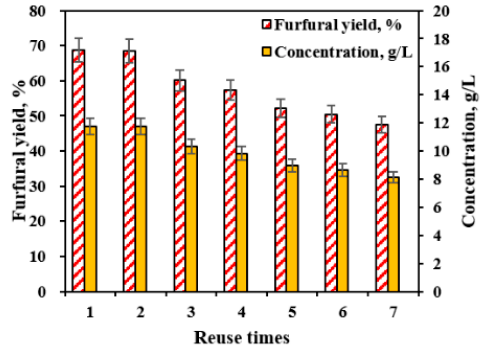
Figure 4. Reuse of CSUTS-CSW in toluene–water (2:1, v : v ) (75 g/L CC, 3.6 wt% CSUTS-CSW, NaCl (200 mM), 180 °C, 15 min) (± Standard error ( n = 6), p ≤ 0.05).